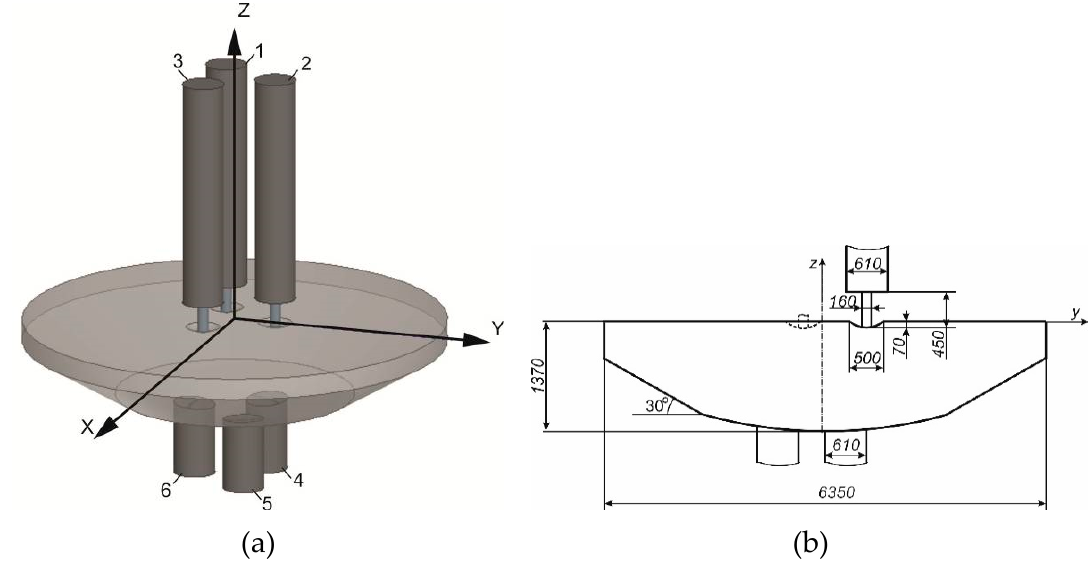
Figure 1. The geometric model of the furnace bath: ( a ) the general view; ( b ) the bath profile in the direction of the Y axis (Unit: mm). In ( a ), 1, 2, and 3 are roof arc electrodes, while 4, 5, and 6 are bottom electrodes.